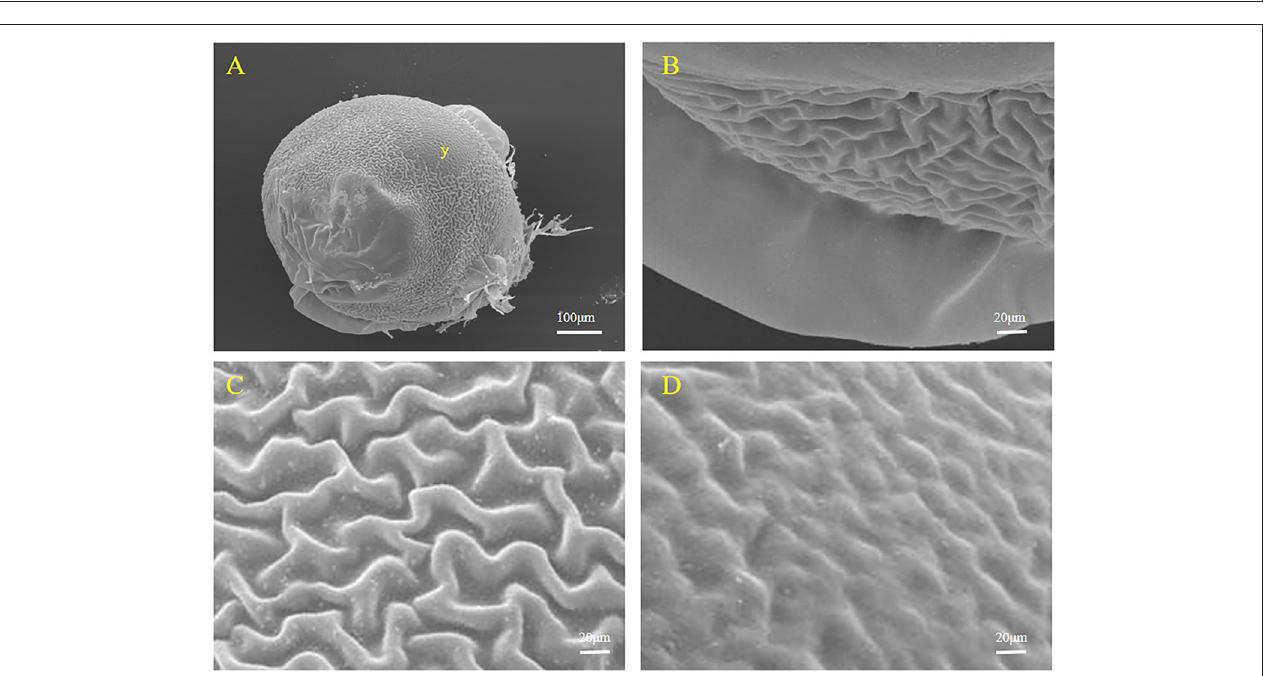
FIGURE 5 | Representative SEM images of the surface of an S. schlegelii embryo. (A) The whole surface of the embryo and the location of the yolk (y). (B) Smooth part of the egg membrane. (C) Folded part of the egg membrane. (D) Area bulging with yolk droplets. Scale bars, 100 µ m (A) ; 20 µ m (B–D) .